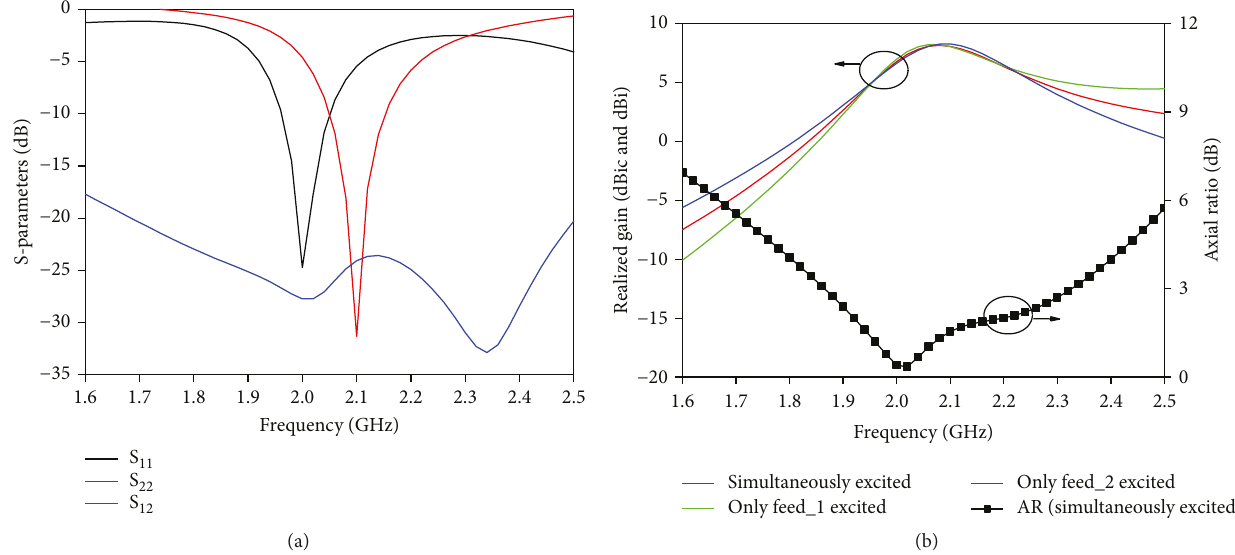
Figure 2: Performances of the patch element. (a) S -parameters. (b) Realized gain and AR.